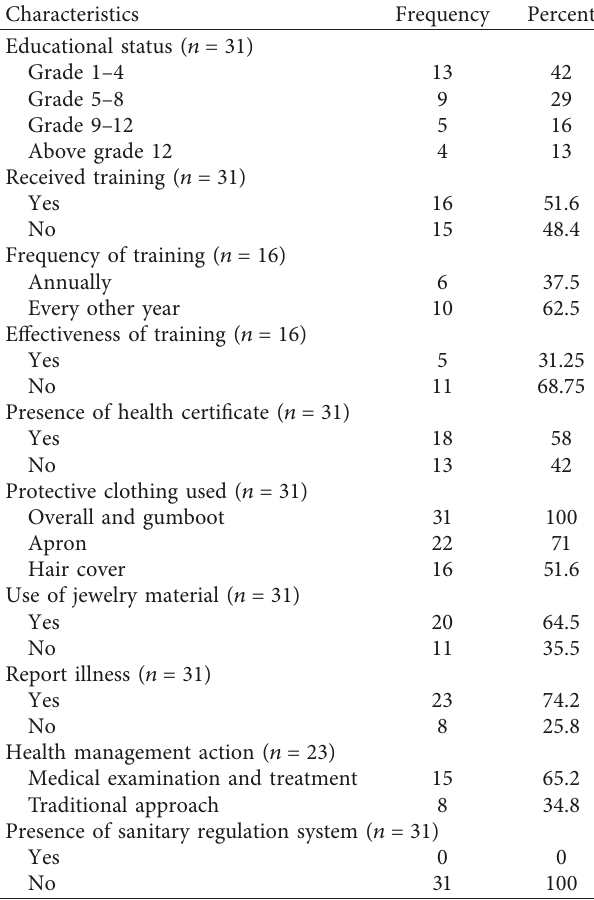
Table 1: Summary on the various hygienic status of the municipal